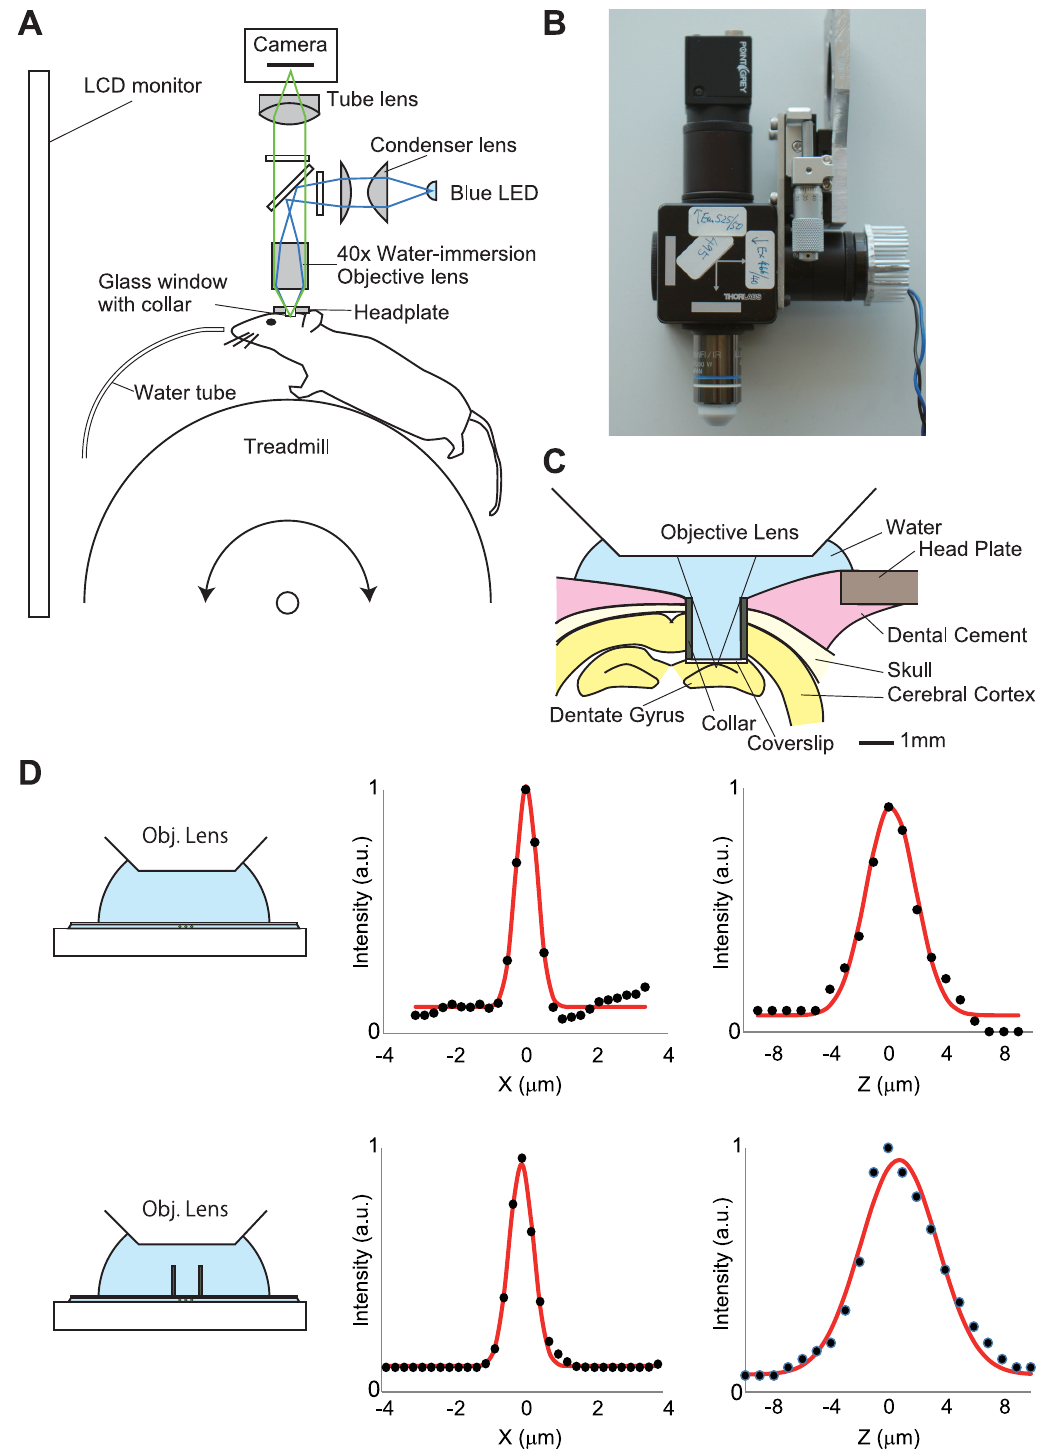
Fig 1. Wide-field imaging systemfor an awake head-restrained mouse. (A) Simplified schematic of the endoscope imagingsystem. The blue line indicatesthe illuminationpathway and the green line indicatesthe light collection pathway. Illumination light from a blue LED was collectedwith a condenserlens, passes through an excitationfilter, reflects off a dichroicmirror, and irradiatedthrough an objectivelens. The fluorescence image was focused on a CMOS